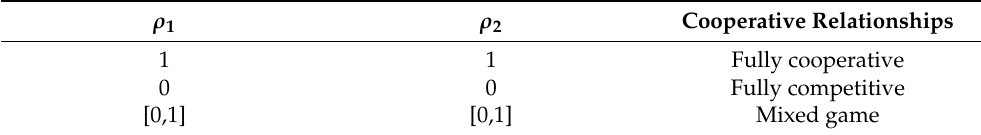
Table 1. Cooperative relationships between multi-ships. ρ